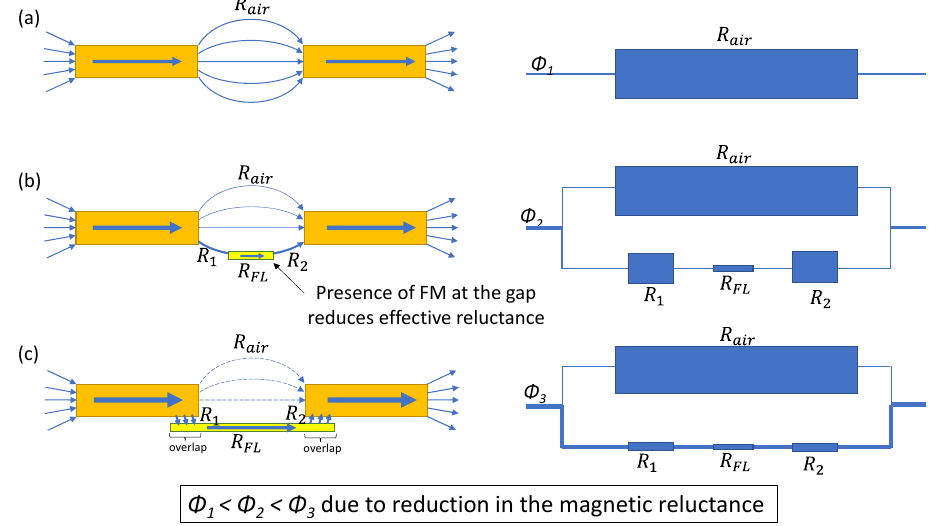
Figure 2. Schematic diagrams showing the effect of the present of an FL on the magnetic reluctance to the magnetic flux flowing through the sensor: ( a ) without FL, ( b ) with FL, and ( c ) with overlap between the MFC and FL.